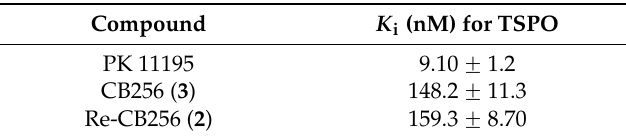
Affinities ( K i /nM) of Re-CB256 ( 2 ) for TSPO from rat C6 glioma cells membranes. Corresponding values for PK 11195 and CB256 ( 3 ) are also reported for